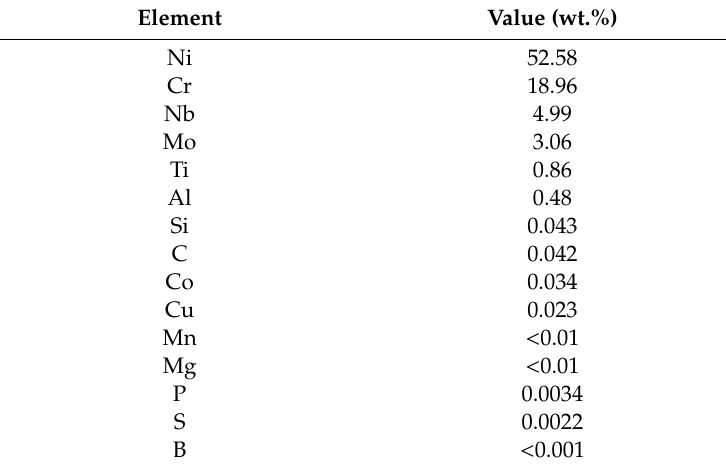
Table 1. The content of IN718 powder